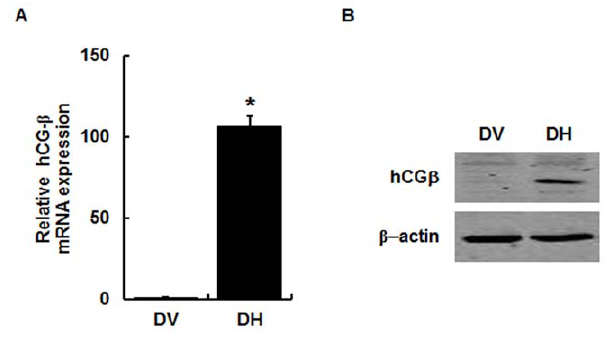
Figure 1. HCG b expression and secretion after the cells were grown for 24 hours. (A) Quantitative analysis of hCG b mRNA and b - actin mRNA transcription in DV and DH cells by Real-time PCR. DV: DU145 cell transfected with empty vector; DH: DU145 cells transfected with hCG b cDNA construct. Note that hCG b mRNA was highly expressed versus control. (B) Analysis of hCG b protein expression by Western blot. b -actin was used for equal loading and normalization. The results indicated that hCG b was highly expressed in DH cells. *, indicates P , 0.05 versus control DV cells. Data were shown as means 6 SEM from three separate tests.